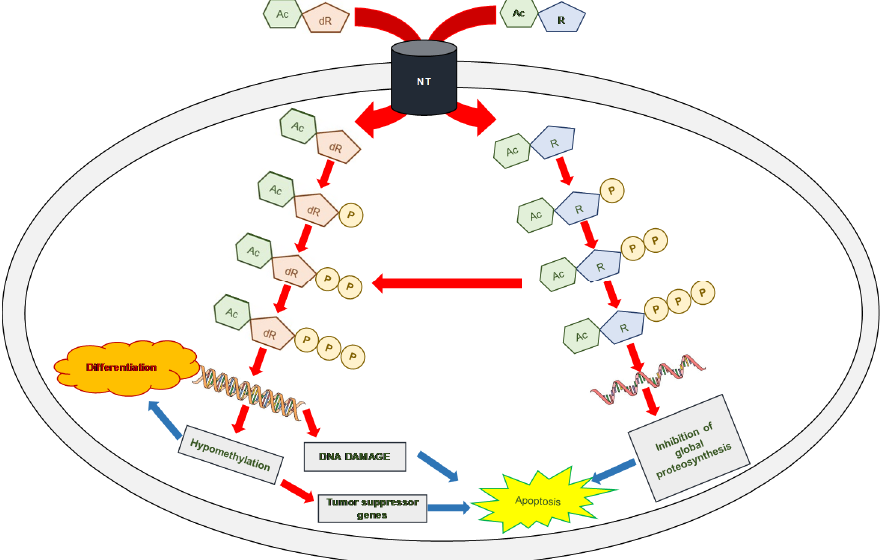
Figure 10. Scheme for gradual phosphorylation of DAC and AZA before they are incorporated into nucleic acids. DAC is incorporated exclusively into DNA, where it causes inhibition of its subsequent methylation and alteration of the gene expression profile. When the promoters of tumor suppressor genes are demethylated, their subsequent expression may initiate controlled cell death processes (most commonly apoptosis). Incorporation of DAC into the DNA structure can result in DNA damage with subsequent initiation of apoptosis (mainly through the intrinsic pathway). In contrast, AZA preferentially incorporates into RNA and causes alterations in the overall metabolism of oligo- and polyconjugates and the subsequent inhibition of global proteosynthesis. Approximately 10–40% of AZA in its nucleotide diphosphate undergoes conversion to the corresponding deoxyribonucleotide diphosphate by ribonucleotide diphosphate reductase and is incorporated into DNA.